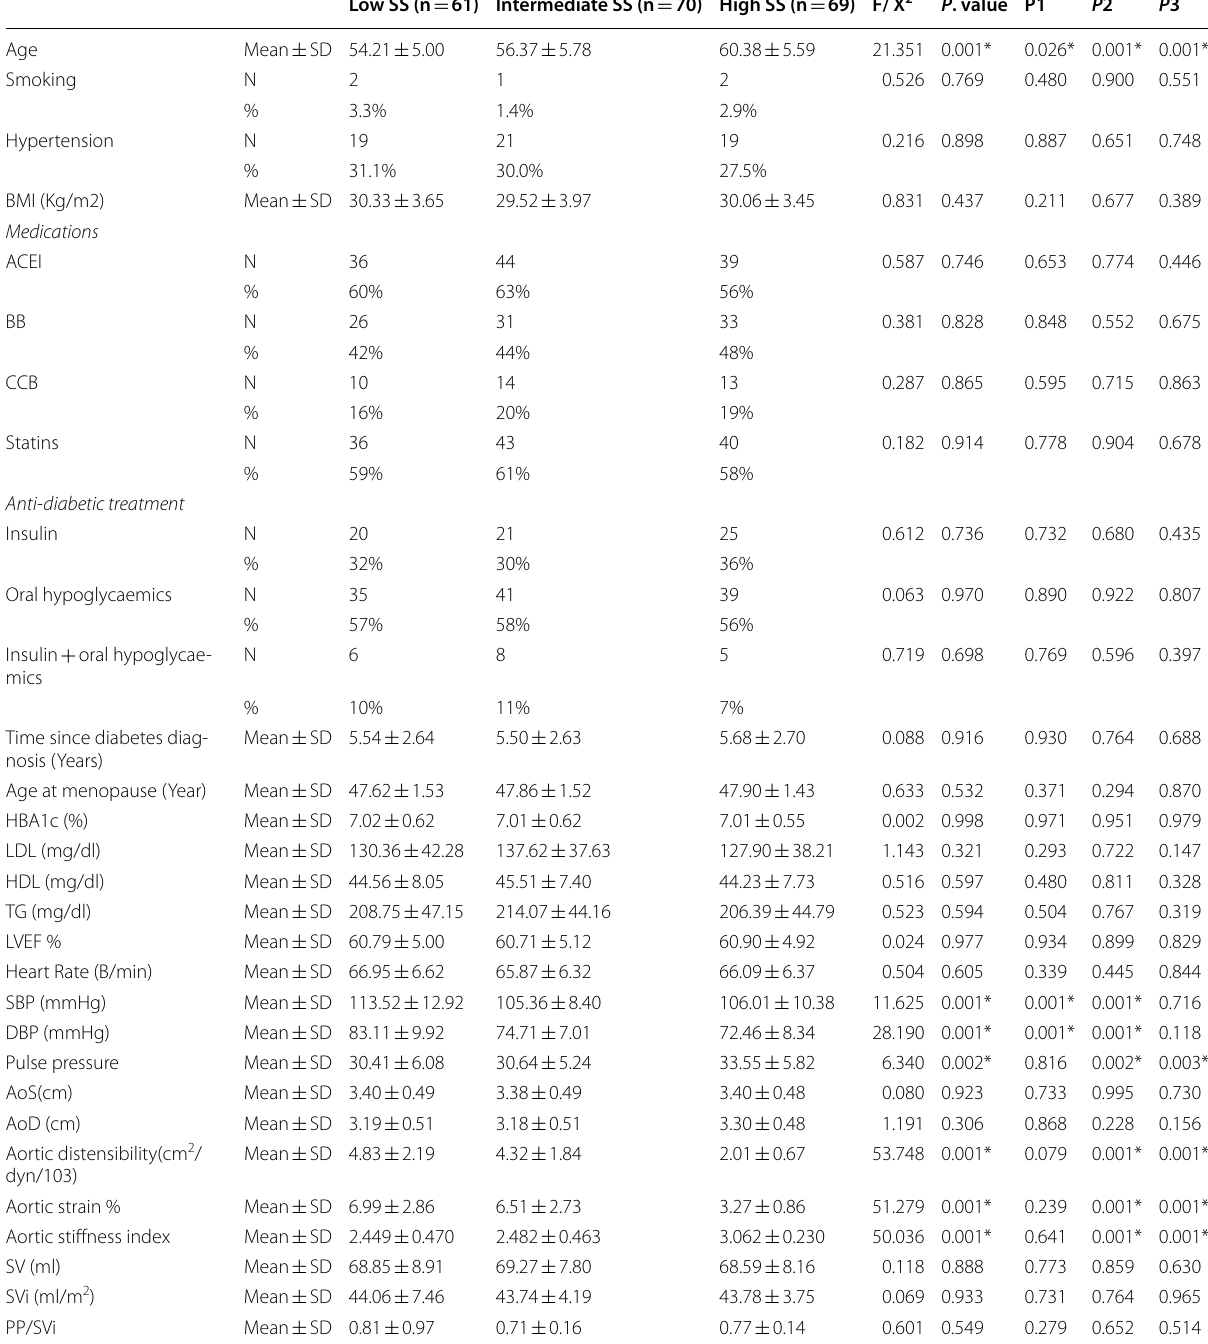
P1, significance between Low & Intermediate SS; P2, significance between Low & High SS; P3, significance between Intermediate & High SS; SS, YNTAX score; HBA1c, Haemoglobin A1c; LDL, Low-Density Lipoprotein; HDL, Low-Density Lipoprotein; TG, Triglycerides BMI, Body Mass Index; ACEI, Angiotensin-converting enzyme inhibitors; BB, Beta-blockers; CCB, Calcium channel blockers; B/min (beat/ minute); LVEF, Left Ventricular Ejection Fraction; SBP, Systolic Blood Pressure; DBP, Diastolic Blood Pressure; AO, Aorta;SV, Stroke Volume; SVI, Stroke Volume Index; PP, Pulse